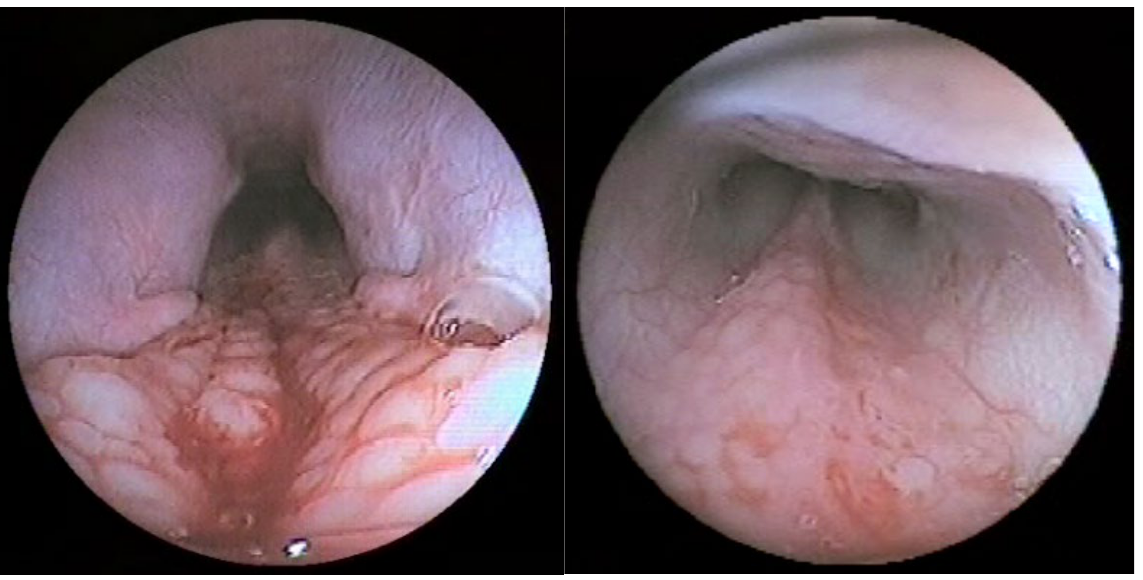
Figure 2. Endoscopic images of the nasopharynx of a dog with reverse sneezing showing extensive follicular inflammation, both in the caudodorsal portion of the nasopharynx ( left ) and extending rostrally to the end of the nasal septum ( right ).